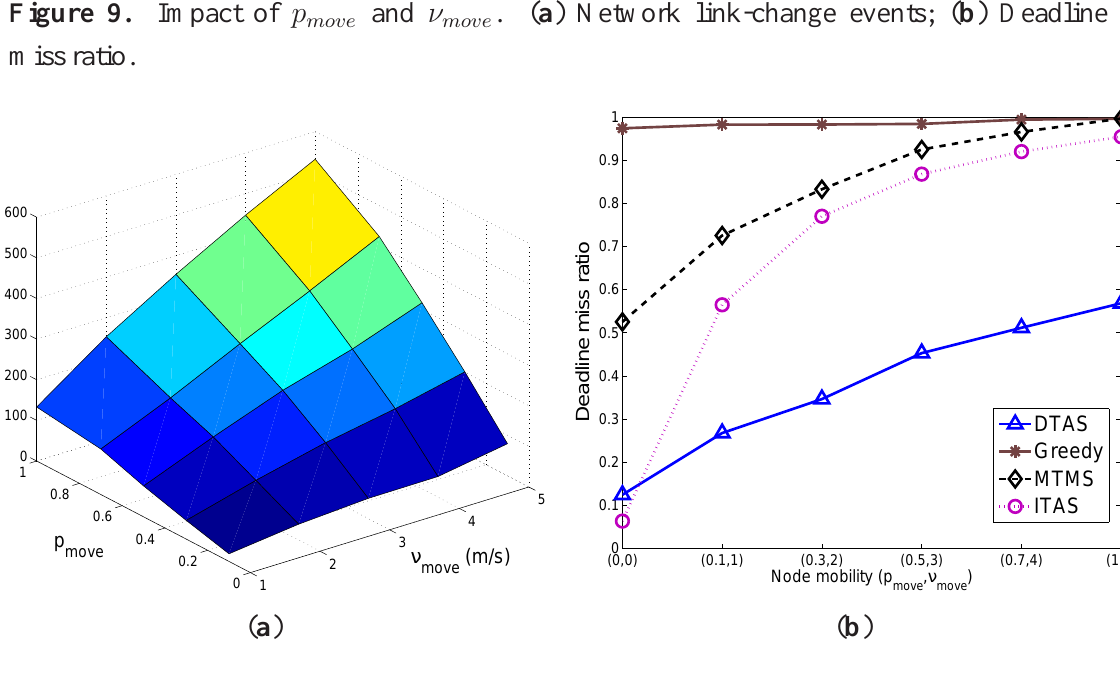
( a ) Network link-change events; ( b ) Deadline